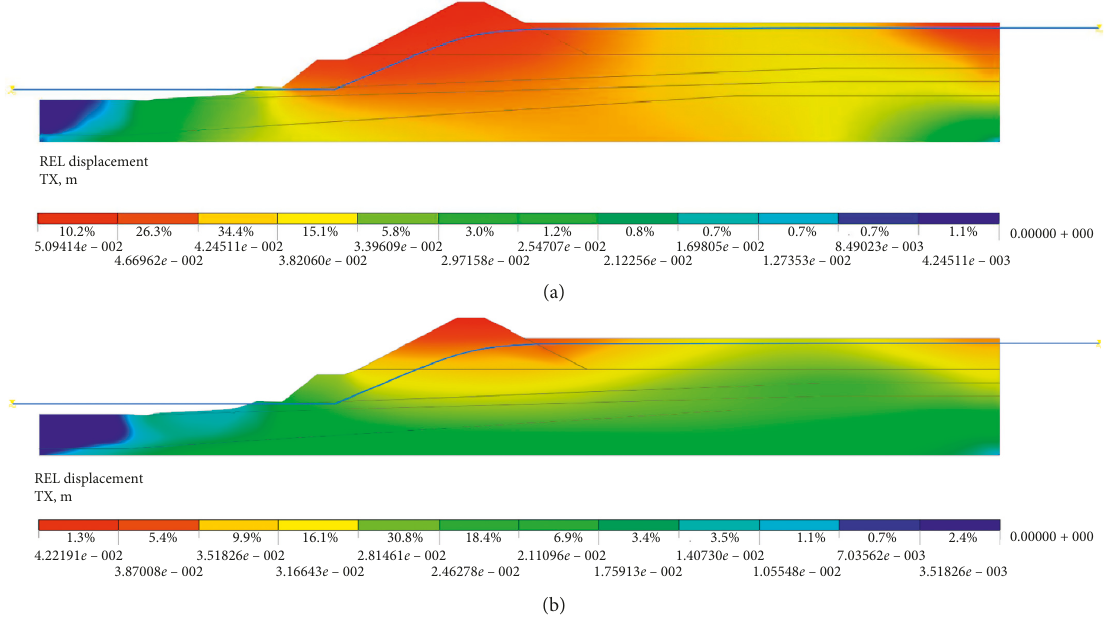
Figure 17: Displacement contour of the subgrade before and after strengthening. (a) Displacement contour of the subgrade before strengthening. (b) Displacement contour of the subgrade after strengthening.